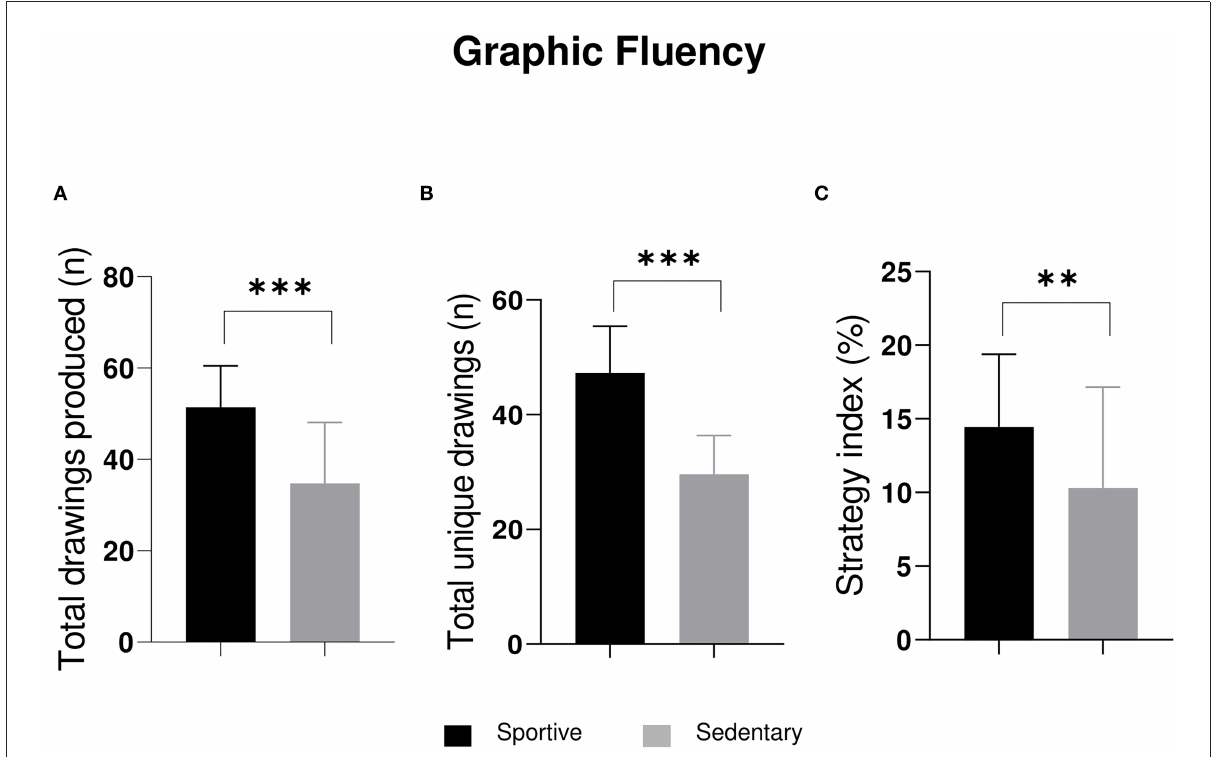
FIGURE2 The 2 × 2 ANOVA significant outputs on (A) total drawings produced, (B) total unique drawings, and (C) strategy index. ** p ≤ 0.01; *** p ≤